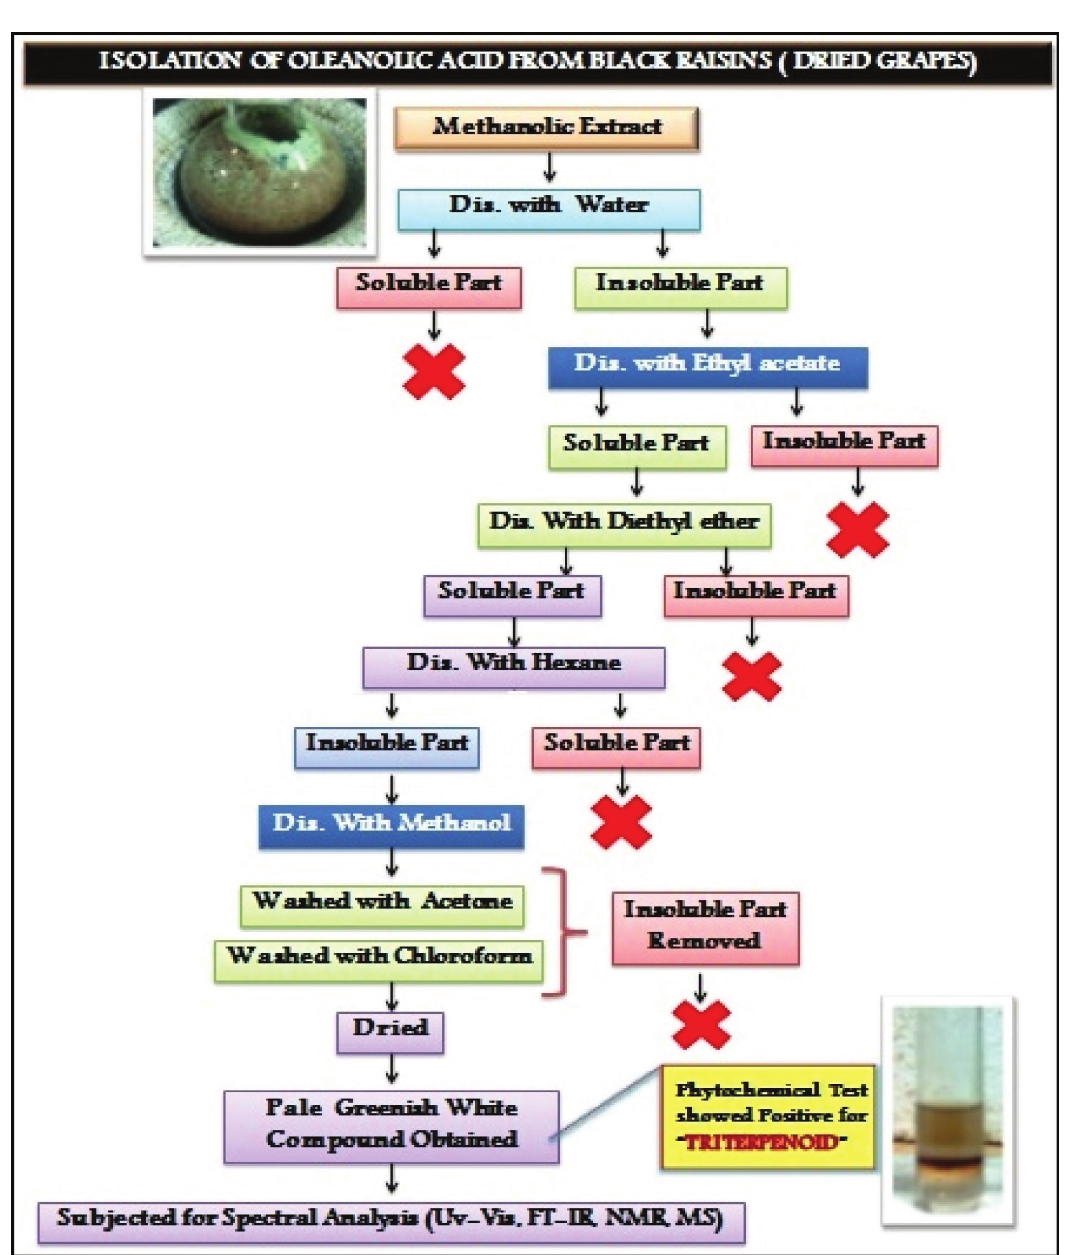
FIGURE 1 - Flow chart of isolation of oleanolic acid from the black